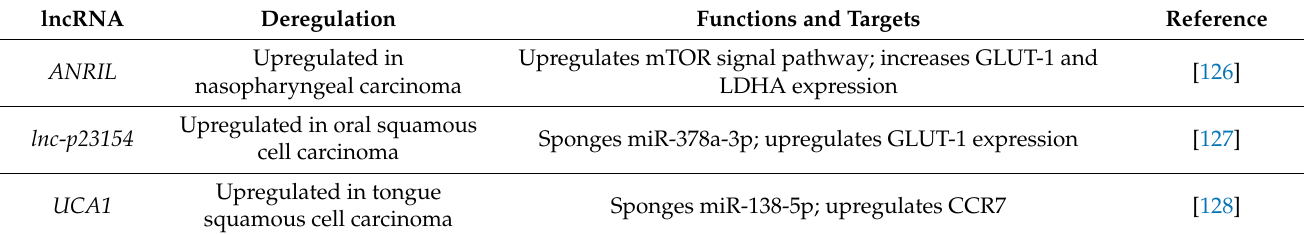
Table 9. Examples of lncRNAs implicated in glucose metabolism alteration in head and neck cancer. lncRNA Deregulation Functions and Targets Reference Upregulated in ANRIL nasopharyngeal